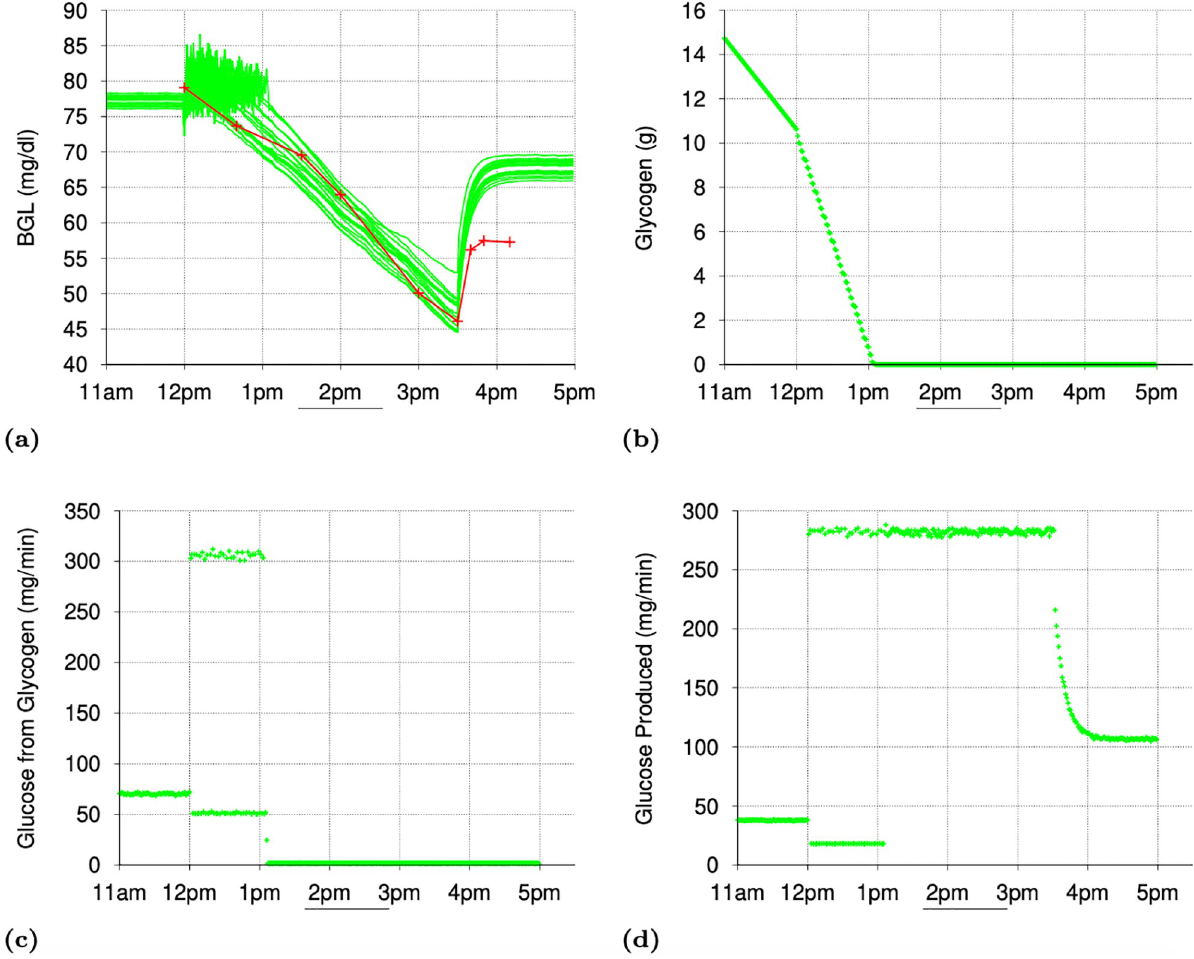
Fig 3. Results of simulations replicating a physical exercise event at intensity 58% VO 2 max as reported in [51]. (a): Green: BGL for 20 simulated subjects; Red: average BGL reported in [51]. (b): Liver glycogen for the subject # 1. (c): Liver glycogen breakdown for the subject # 1. (d): Total gluconeogenesis in Liver and Kidneys for the subject #